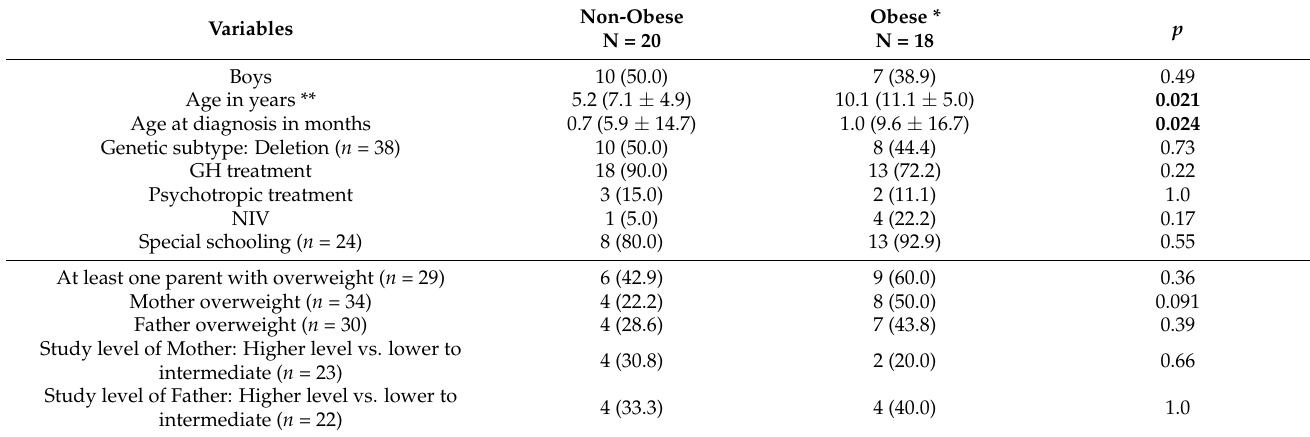
Table 2. Characteristics of children with deprivation and their families classified by obesity. Variables are expressed in n (%) or in Med/Mean ± SD; for continuous variables (age, age at diagnosis, BMI Z-score, HQ, HQ-CT) p was calculated using Student or Wilcoxon test; for categorical variables (gender, genetic diagnosis, special schooling, parent’s obesity, study level of parents, treatment of GH/Psychotropic treatment, NIV, deprivation) p was calculated using Chi2 or Fisher exact test.